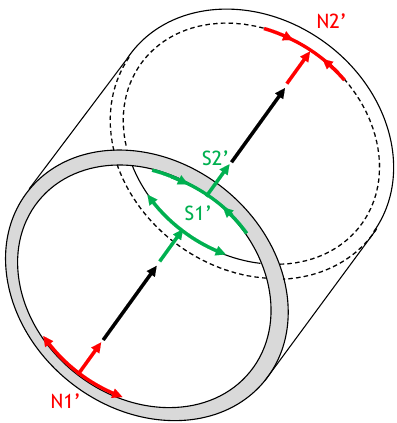
Figure 3. SCP, two imaginary saddle–node combination for a portion of cylindrical